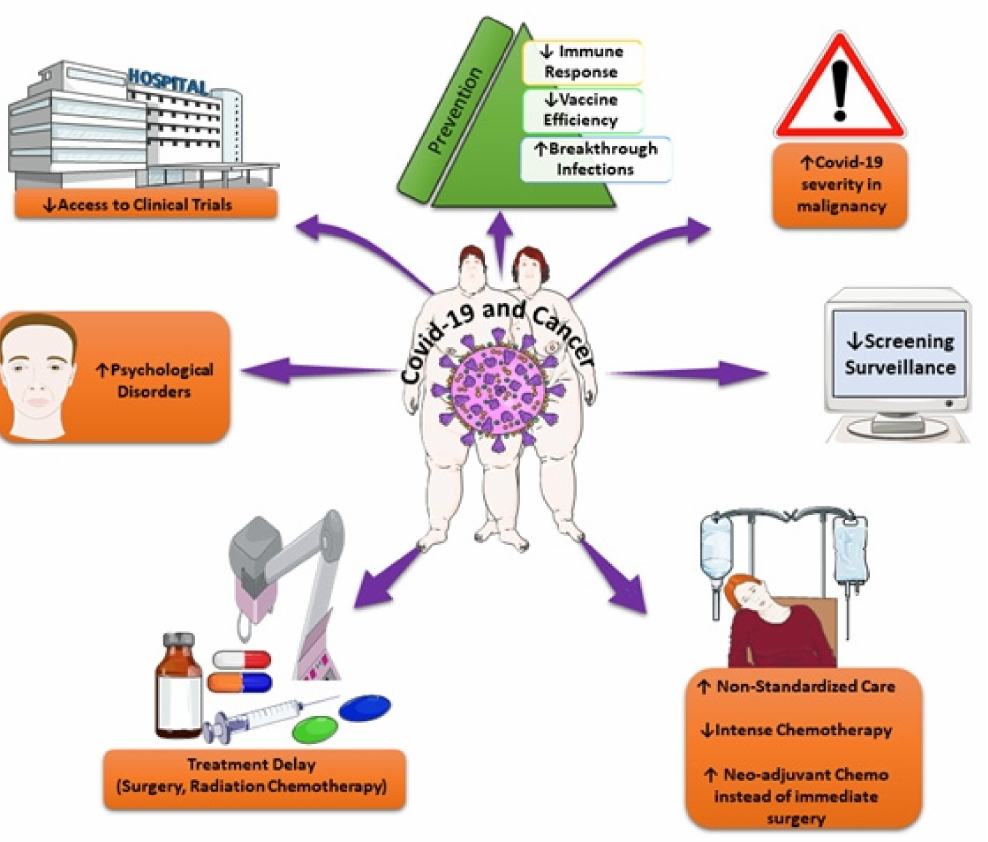
Figure 1. Main challenges of COVID-19 associated with cancer. This image was derived from the free medical site http://smart.servier.com/ (accessed on 2 March 2023) by Servier, licensed under a Creative Commons Attribution 3.0 Unported